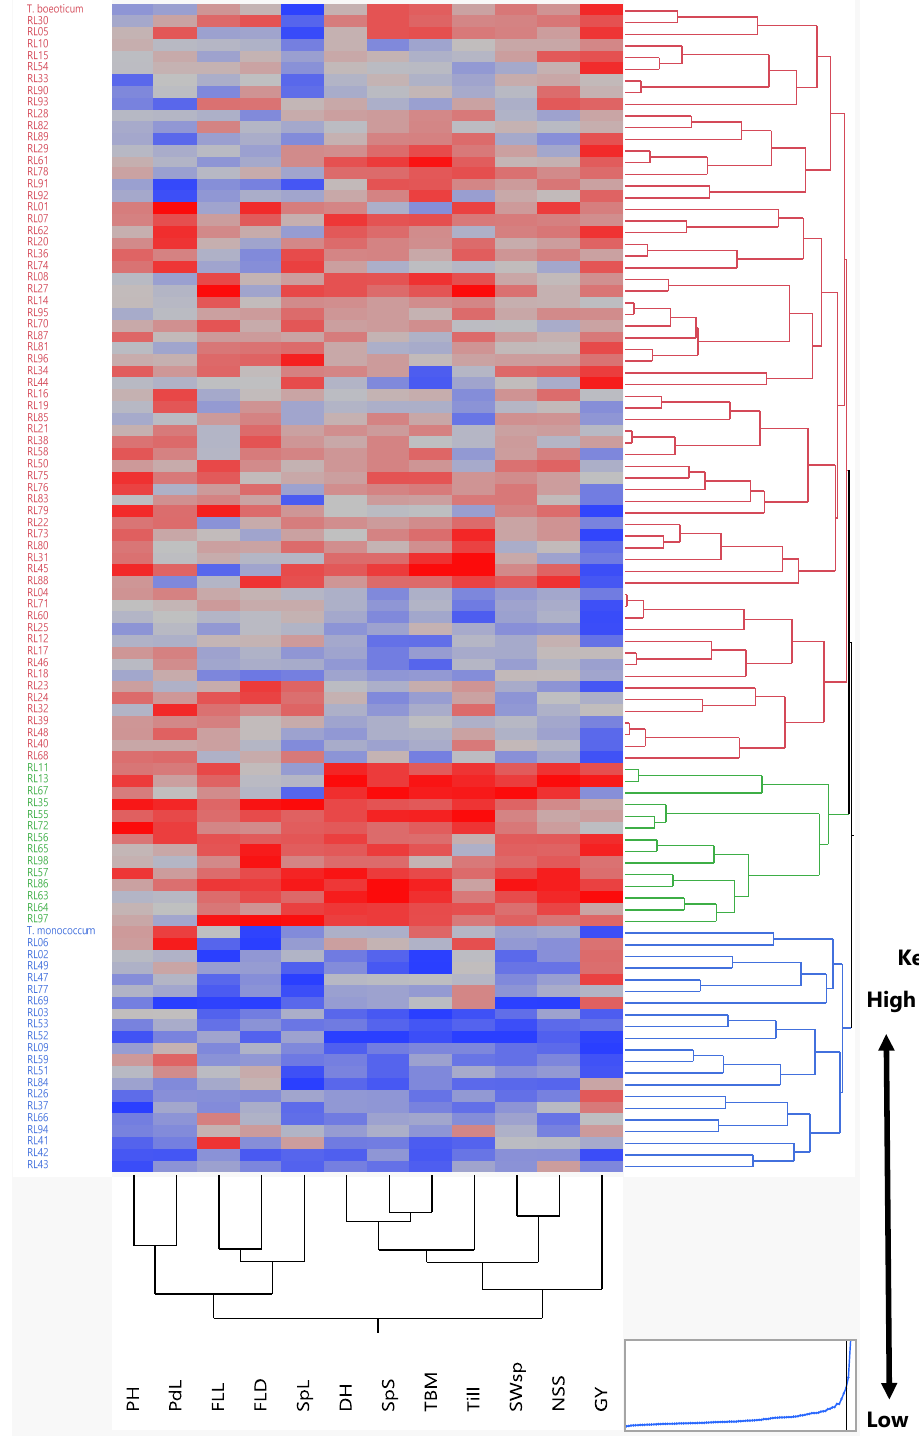
Figure 6. Agglomerative hierarchical clustering (AHC) to calculate the Euclidean distance matrix of parental genotypes and 98 RILs. The plot was constructed in JMP pro. V. 16 (SAS Institute Inc., Cary, NC, USA) using Ward’s minimum variance on standardized data The horizontal axis and vertical axis represent clades formation based on the division of traits and genotypes, respectively, following the two-way clustering approach.